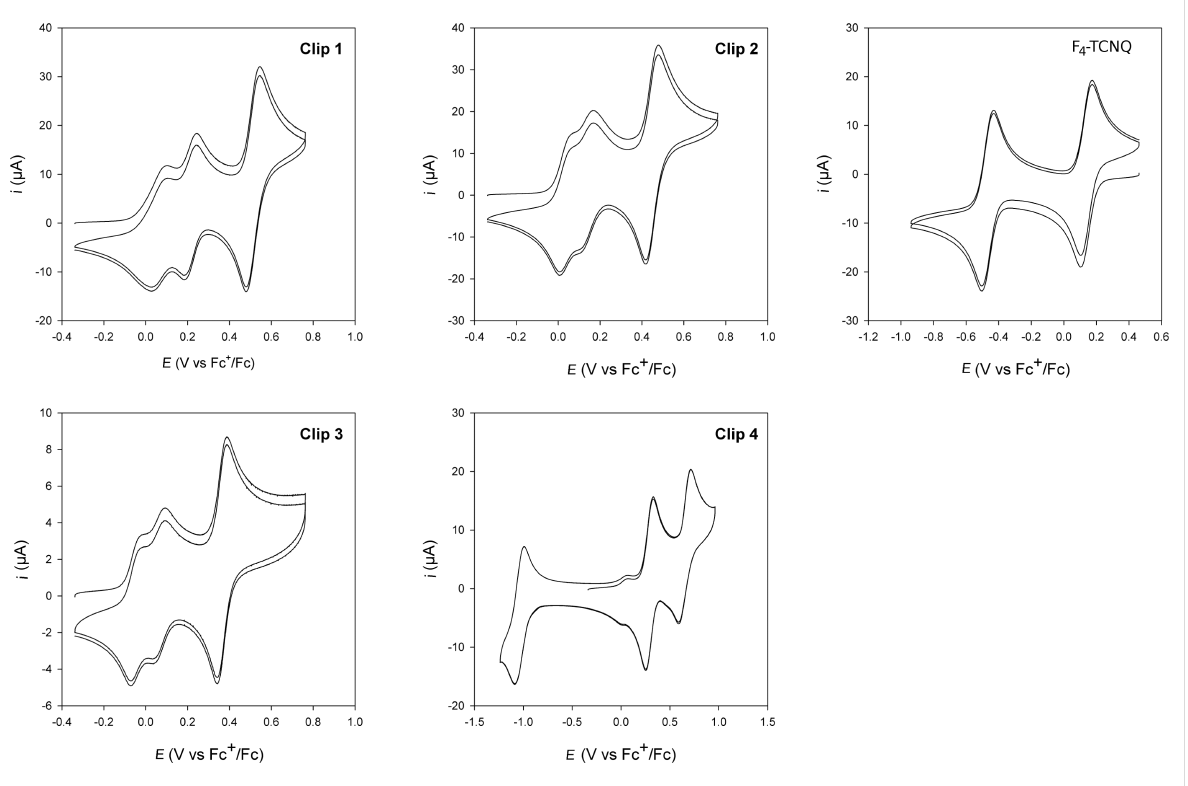
Figure 3: Cyclic voltammograms of molecular clips 1 , 2 , 3 , 4 and F 4 -TCNQ at 10 − 3 M in 0.1 M TBAPF 6 /CH 2 Cl 2 /CH 3 CN 3:1 on a glassy carbon elec- trode at 100 mV·s − 1 .